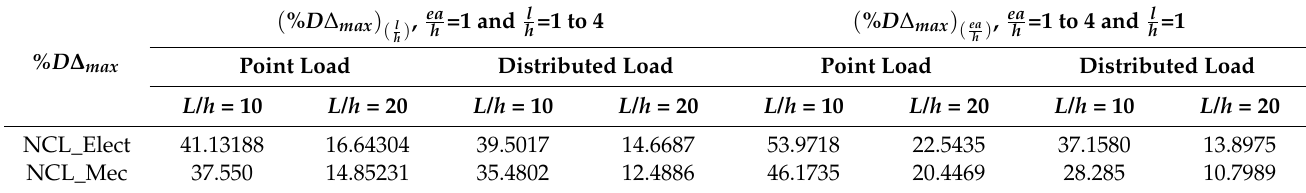
Table 7. The relative percentage difference in the transverse deflection due to increasing the nondi- mensional strain gradient parameter ( l / h ), ( % D ∆ max ) , and the nondimensional nonlocal pa- l / h rameter ( ea / h ), ( % D ∆ max ) , for electromechanical and mechanical nonclassical behaviors un- ea / h der point and uniformly distributed loads at beam aspect ratio L / h = 10, 20, e 311 = − 4.1 C/m 2 ,